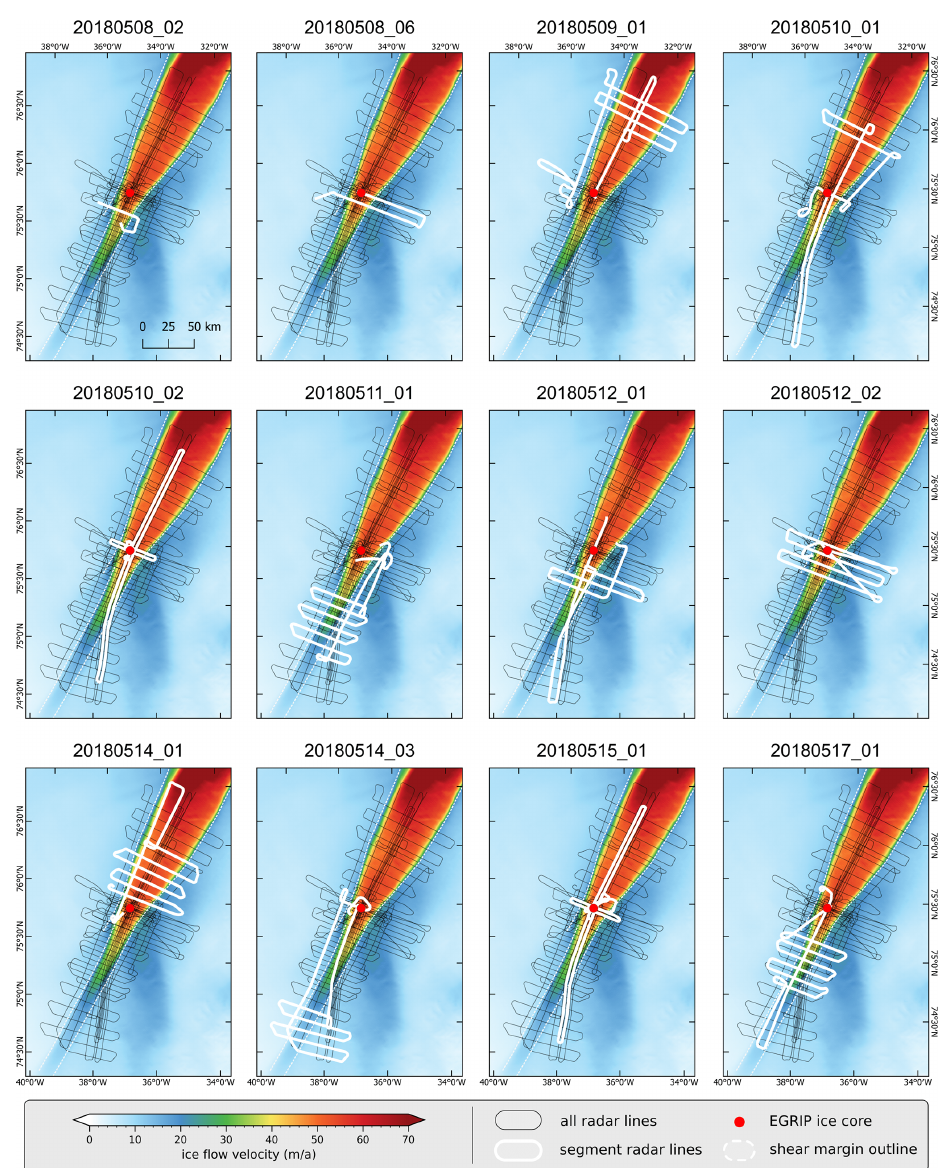
Figure A1. Radar profile locations of the 12 segments shown in Table A1 of the EGRIP-NOR-2018 data set. The respective segments are highlighted with a white line and the radar profiles of the complete survey with a finer black line. The background map represents ice surface velocity from Joughin et al. (2017). The shear margin is indicated with a dashed white outline and the location of EastGRIP with a red dot.